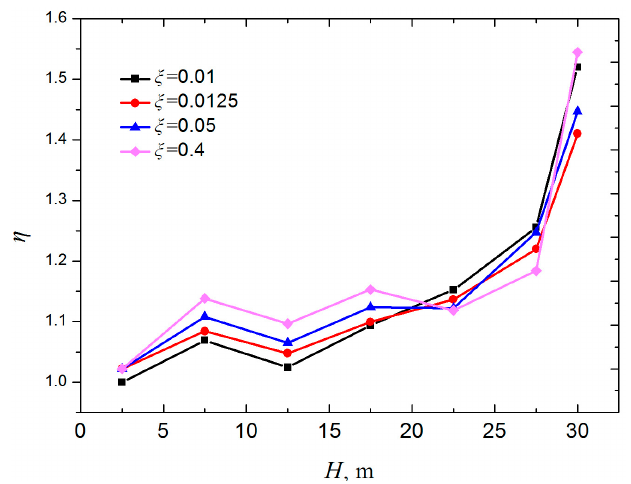
Figure 12. The acceleration amplification coefficient of monitoring points on the oblique slope surface with different ξ ( ξ = 0.01 to 0.4) (where K = 0.5).